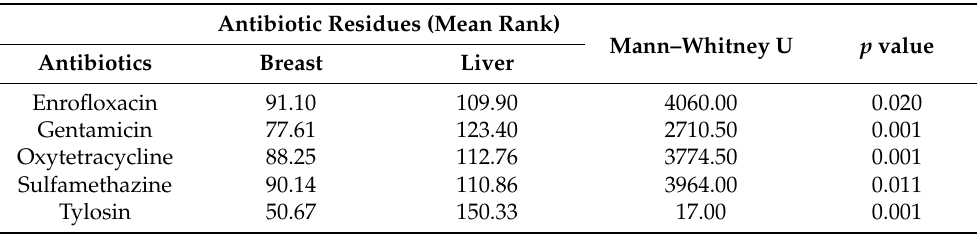
Table 2. Mean rank comparison of antibiotic residue concentrations ( µ g/kg) between breast and liver tissues of broiler chickens using Mann–Whitney U